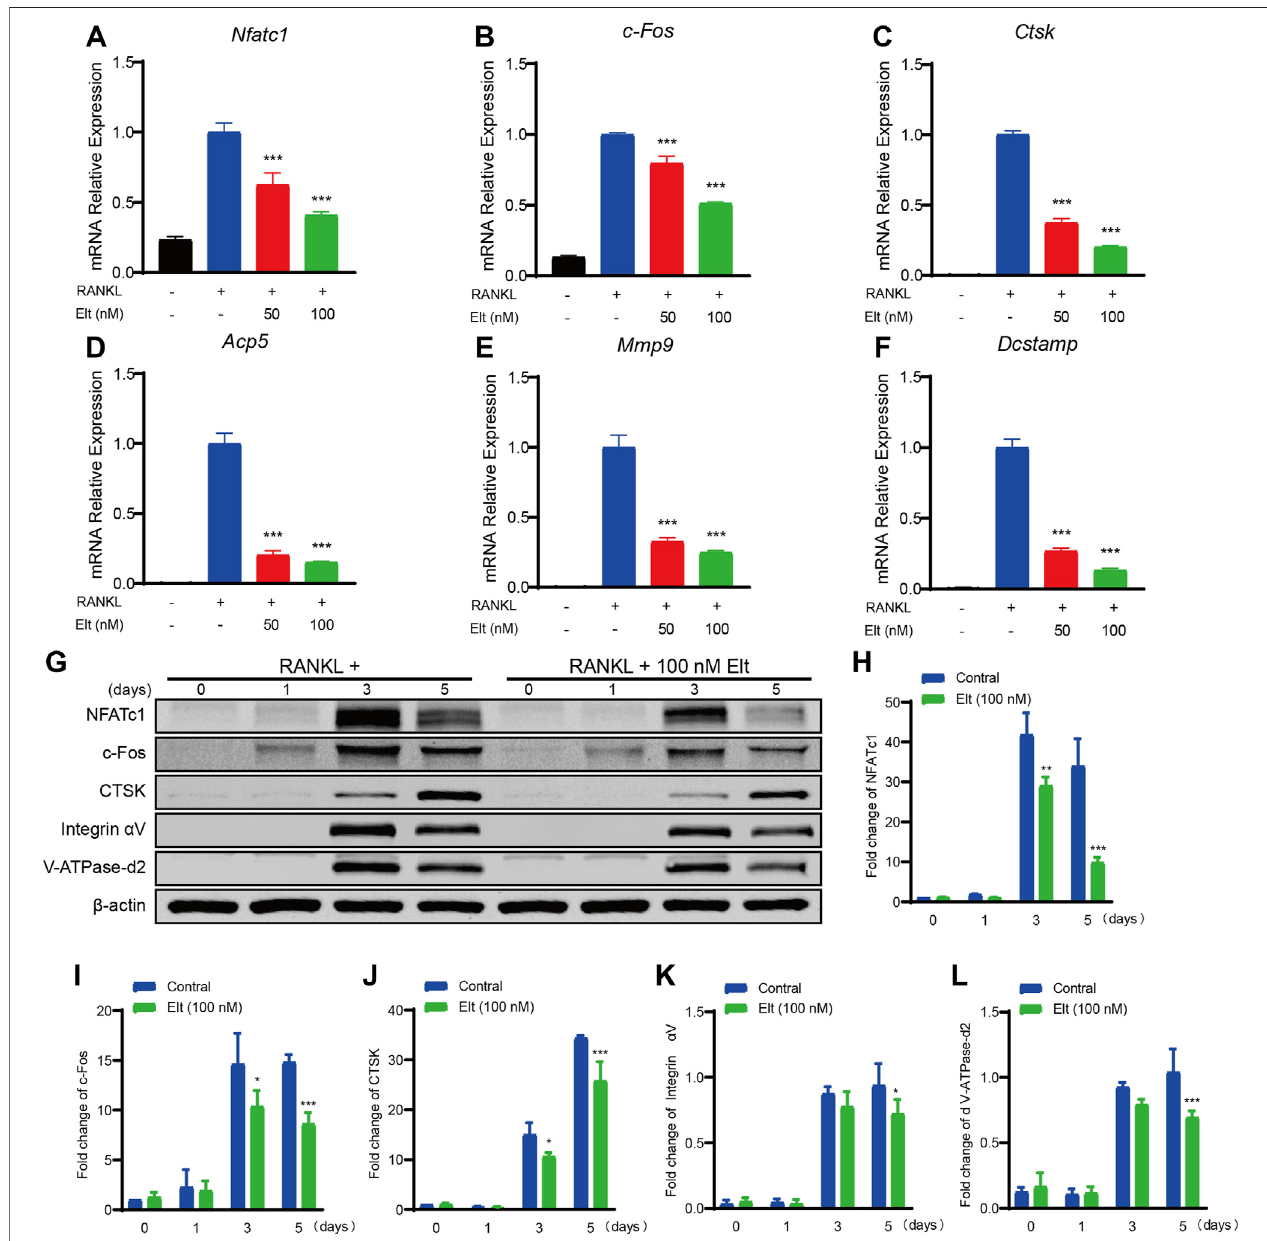
FIGURE 4 | Elt inhibits expression of characteristic genes and proteins of osteoclasts. (A – F) The expression levels of the osteoclast-related speci fi c genes Nfatc1, c-Fos, Ctsk, Acp5, Mmp9 and Dcstamp were analyzed by qPCR. (G) BMMs were stimulated with RANKL, with or without 100 nM Elt for 0, 1, 3, and 5 days, the expressionofcharacteristicproteinswastestedbywesternblots. (H – L) Theexpressionofalltheproteinsmentionedabovewasstandardizedto β -actinexpression.The above data are expressed as the mean ± SD; n = 3; *p < 0.05 relative to RANKL-induced controls.